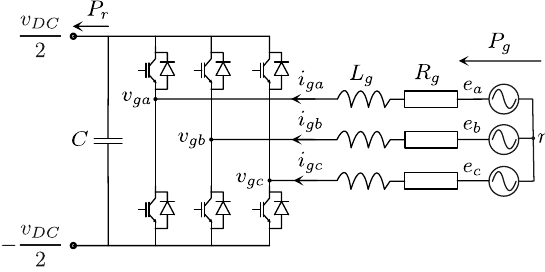
Figure 3. Scheme of the GSC and L-type grid